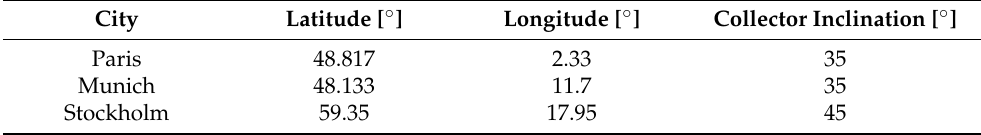
Table 7. GPS coordinates and inclination of solar collectors.